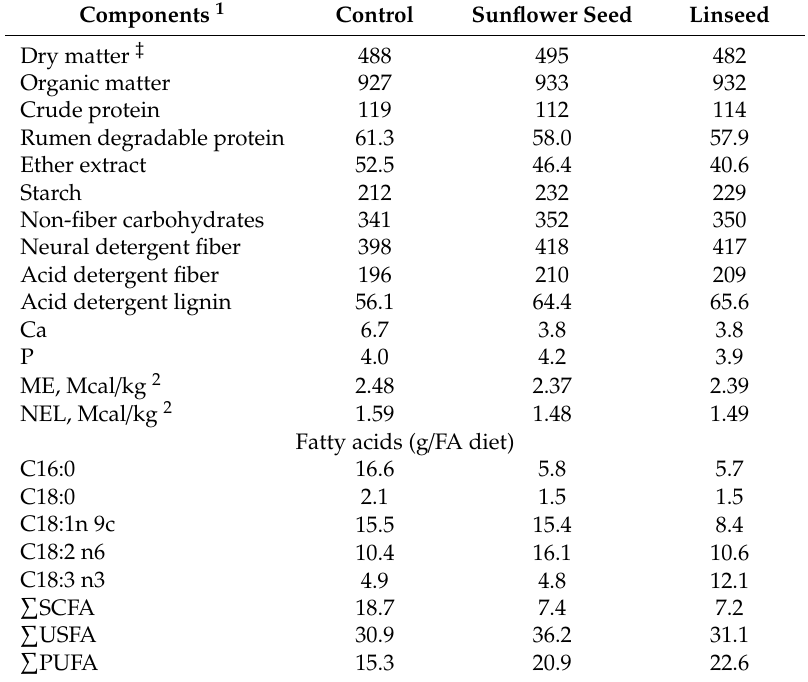
Table 2. Chemical composition, nutritional value and fatty acid profile from control (Megalac-R ®